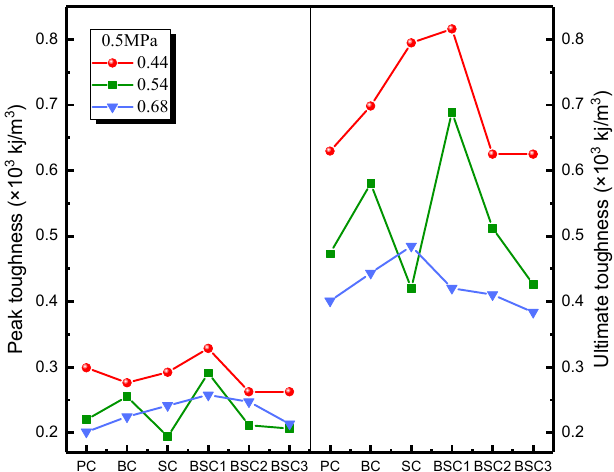
Figure 17. Fiber hybridization effect on impact toughness of BSFRC.